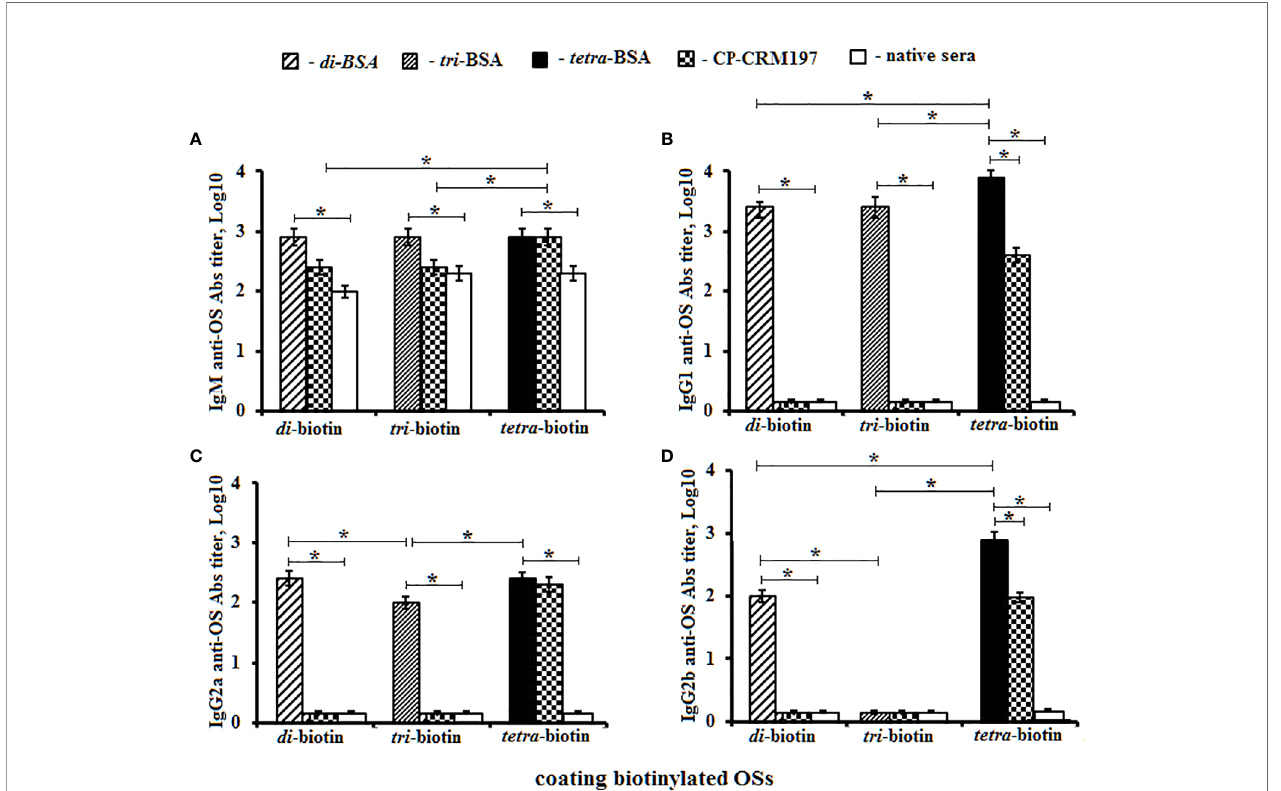
FIGURE 5 | Anti-OS antibody (Ab) classes in pooled sera of BALB/C mice (n = 6) immunized with OS – BSA and CP – CRM 197 conjugates. The biotinylated OSs (di – , tri – , and tetra – biotin) were applied as coating antigens. (A) IgM anti-OS Abs. (B) IgG1 anti-OS Abs. (C) IgG2a anti-OS Abs. (D) IgG2b anti-OS Abs. IgG3 level was low (<1:100) and not presented (three assays per antiserum). Ab titers were transformed to log 10 . Data are displayed as a mean value ± SD. Mann – Whitney Rank Sum tests were used to determine signi fi cance. * P <